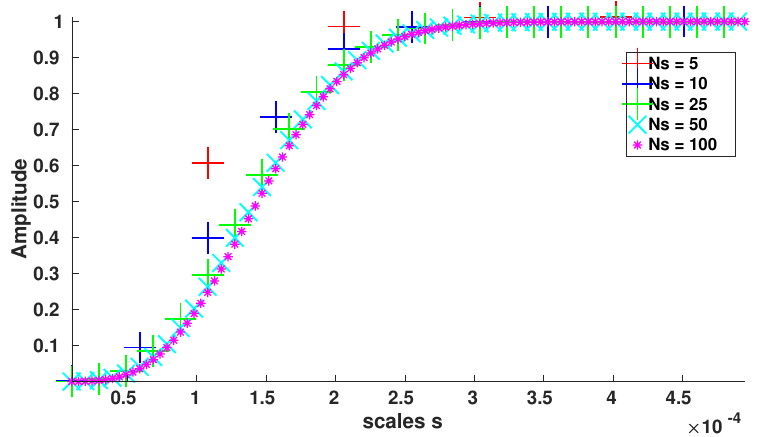
Figure 9. Pressure L 2 -energy recovered for s ∈ [10 − 5 , 5 × 10 − 4 ] - σ = 1 - t = 8 × 10 − 5 s.